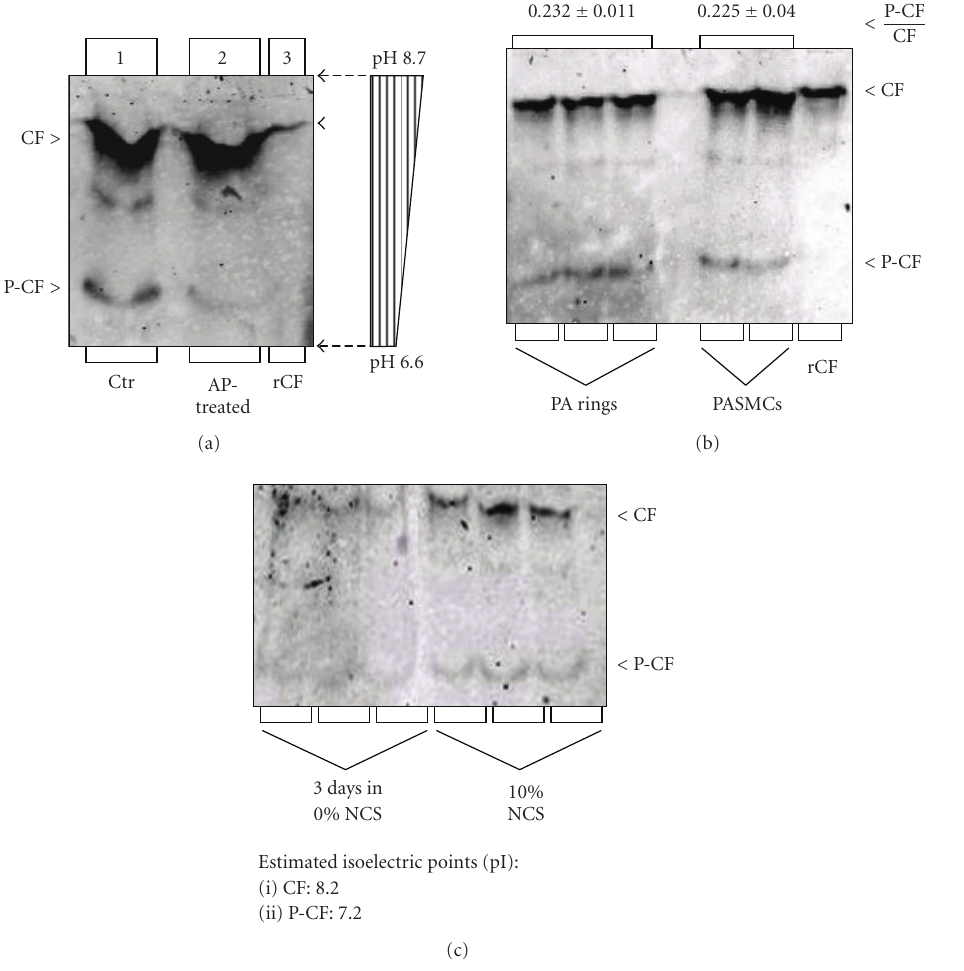
Figure 1: Assay of the phosphocofilin (P-CF) content in canine PA rings and cultured PASMCs by IEF. Total protein from freshly dissected PA rings (panel (a)) and undi ff erentiated and di ff erentiated cells (panel (b)); recombinant CF control (rCF) were resolved by IEF electrophoresis on gels containing 1% of each ampholyte pH 6/8 and 7/9. For CF dephosphorylation, protein extracts were incubated with calf intestinal alkaline phosphatase (AP) prior to IEF electrophoresis. Protein was transferred onto nitrocellulose membranes and membranes were probed with a cofilin antibody that recognizes both unphosphorylated (CF) and phosphocofilin (P-CF). Immunoreactive bands were quantified by densitometry, and treatment-dependent changes of the P-CF/CF ratio were presented relative to untreated controls (Ctr). Vertical strips of gels (0.5cm wide) were cut into 1cm long segments and soaked in deionized water before assay of pH (pH bar in panel A). Panel (c): CF expression is upregulated in proliferating PASMCs (cultured in 10% NCS), compared to di ff erentiated cells (cultured for 4 days in 0%